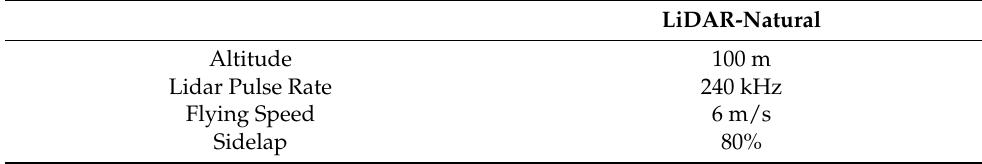
Table 1. The flight parameters of the UAV LiDAR mission.